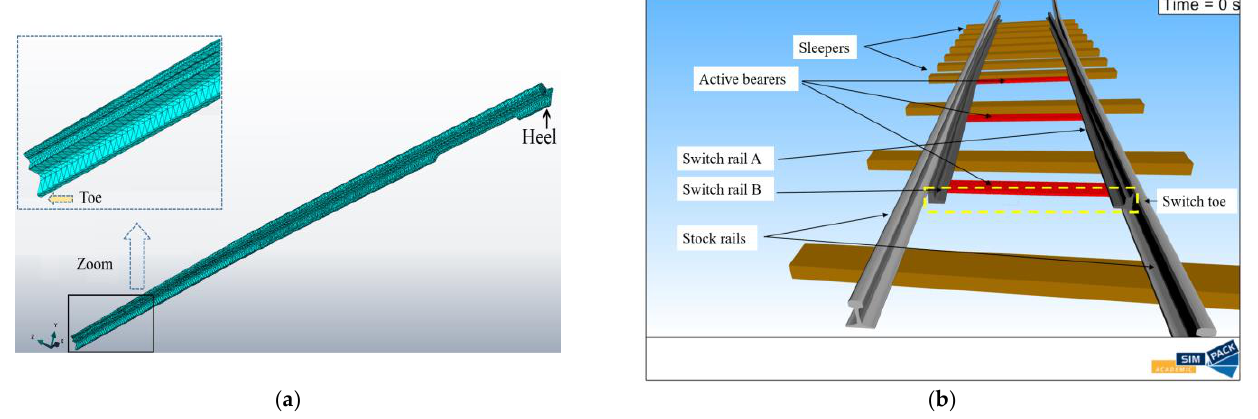
Figure 6. ( a ) Finite Element (FE) model of switch rails, ( b ) Multibody Simulation (MBS) model of the switch panel in Simpack.